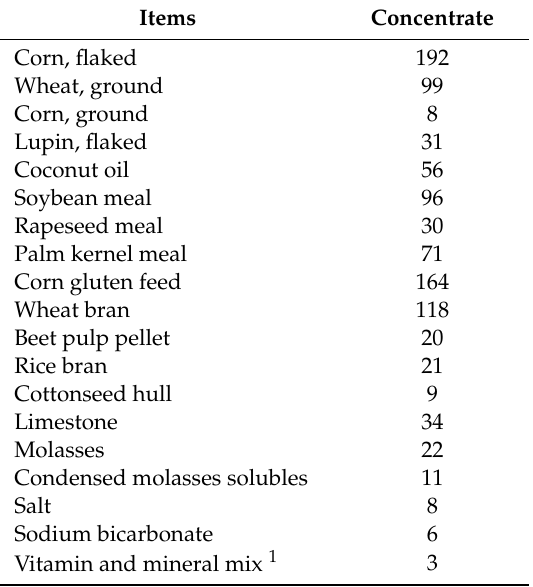
Table 2. Diet composition (g / kg DM or as stated) of the experimental concentrate mix. Items Concentrate Corn, flaked 192 Wheat, ground 99 Corn,